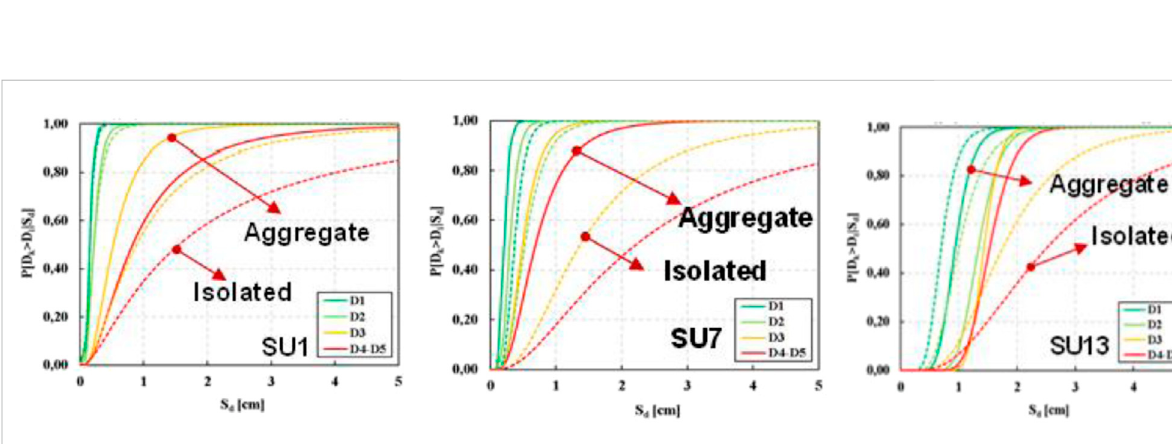
FIGURE 11 Comparison of behaviour between the isolated buildings and aggregate